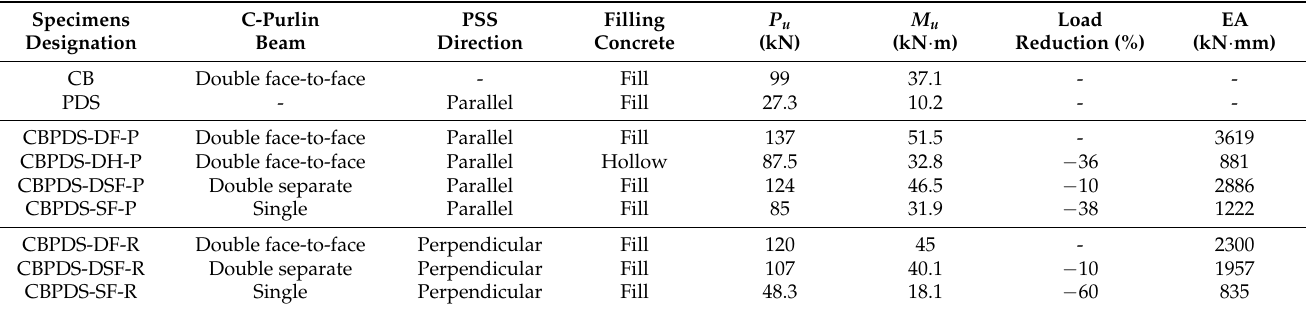
Figure 2. Specimens designation ID. Table 1. Designations and results of the tested